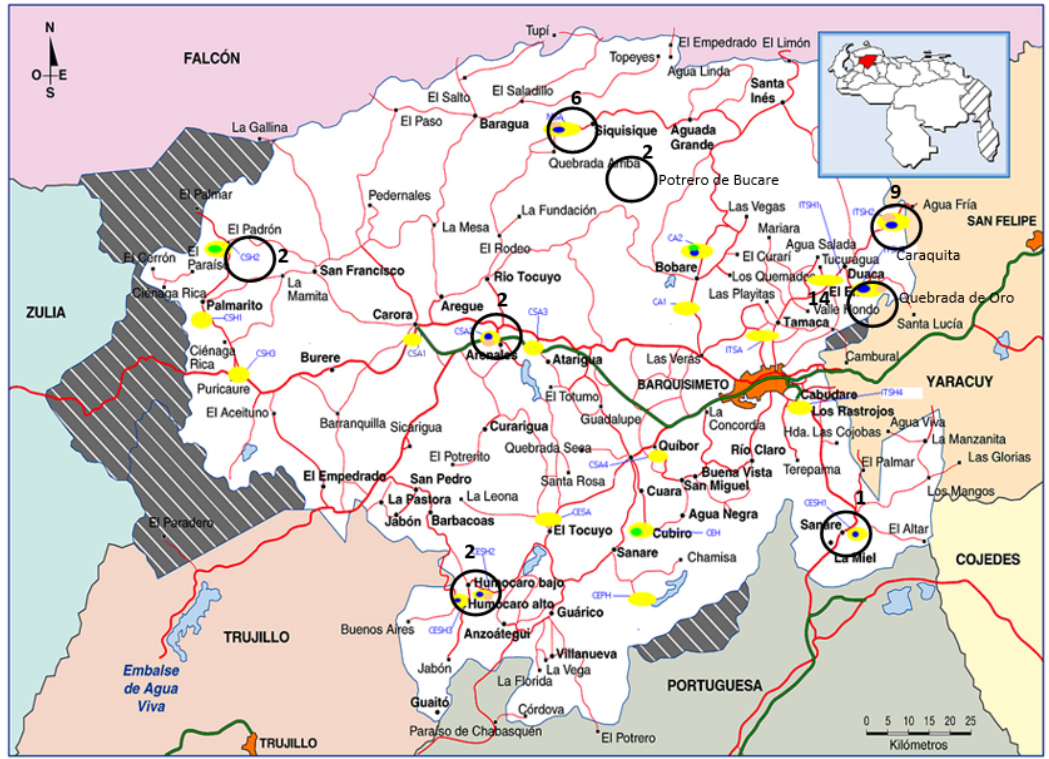
Figure 1. Geographic distribution of soil Nocardia strains collected in Lara State (Venezuela). Numbers indicate the number of strains isolated per site.